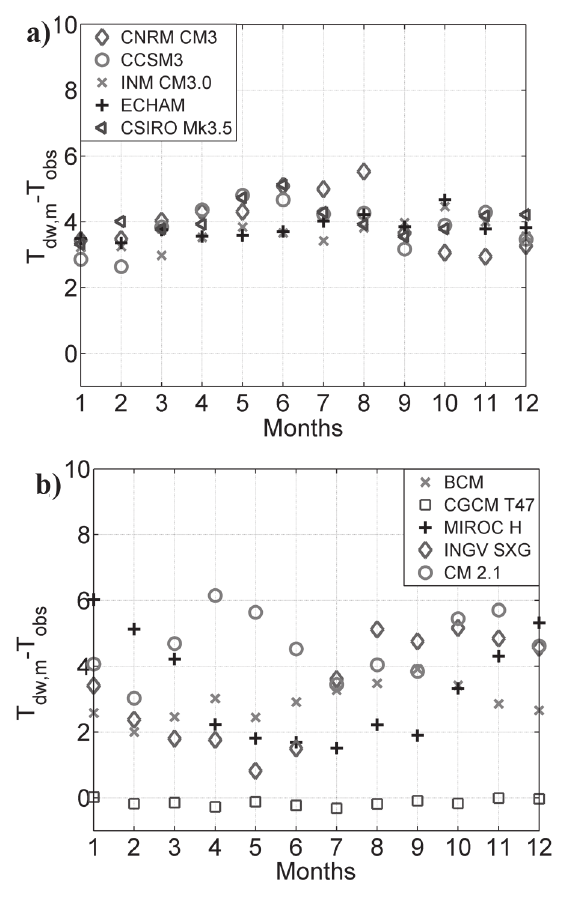
) for Figure 8 - Baseflow simulated by SPA groundwater model and dw,m estimated using a digital